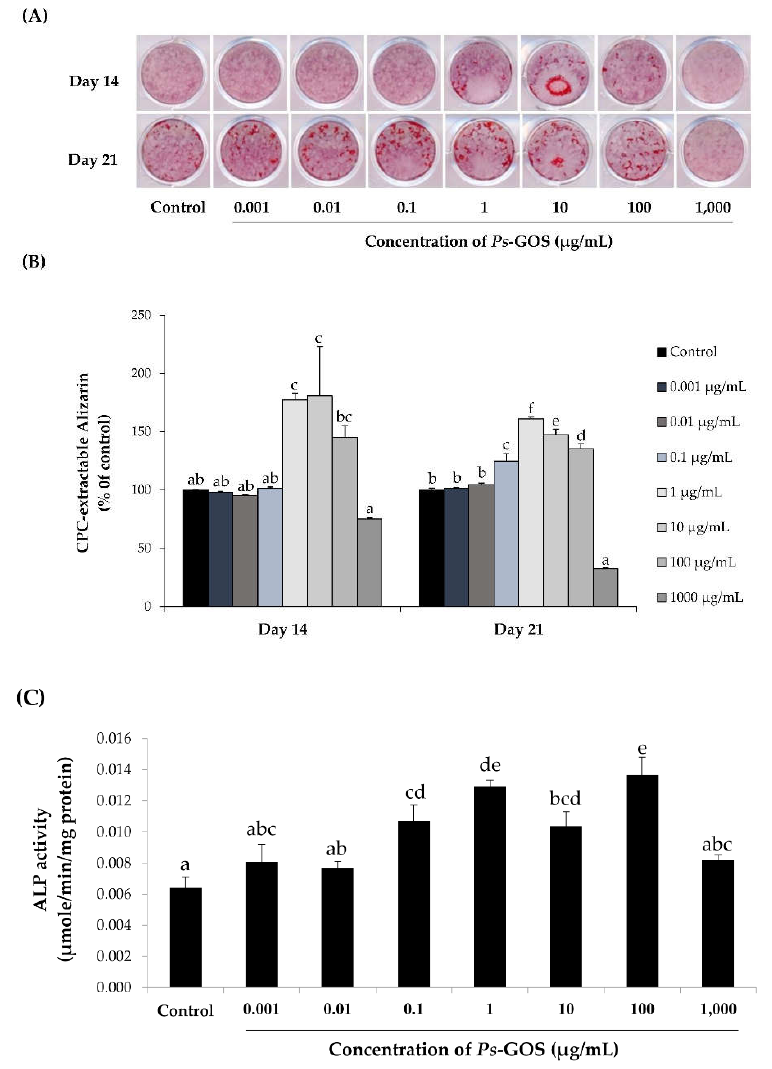
Figure 3. The effect of different concentrations of Ps -GOS on osteoblastic differentiation and mineralization of MC3T3-E1 cells. ( A ) Cells were treated with Ps -GOS for 14 and 21 days for observing the calcium accumulation measured by Alizarin red S staining. ( B ) Quantitative data of mineralization process relate to the intensity of Alizarin red S stains extracted by cetylpyridinium chloride. ( C ) Alkaline phosphatase (ALP) activity of MC3T3-E1 cells after treatment with Ps -GOS for 14 days. Each point of data represents the means of four replicate samples ± SEM. The data in columns with different letters in each group were significantly different at p < 0.05.